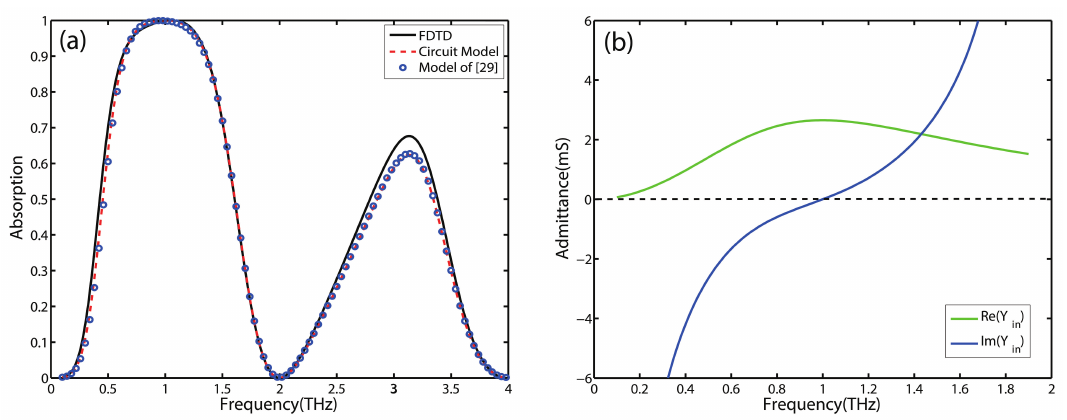
Figure 3. ( a ) The absorption spectrum of the designed perfect absorber with the central frequency at 1 THz simulated by FDTD simulations and calculated by circuit model. ( b ) Real and imaginary parts of the input admittance of the designed